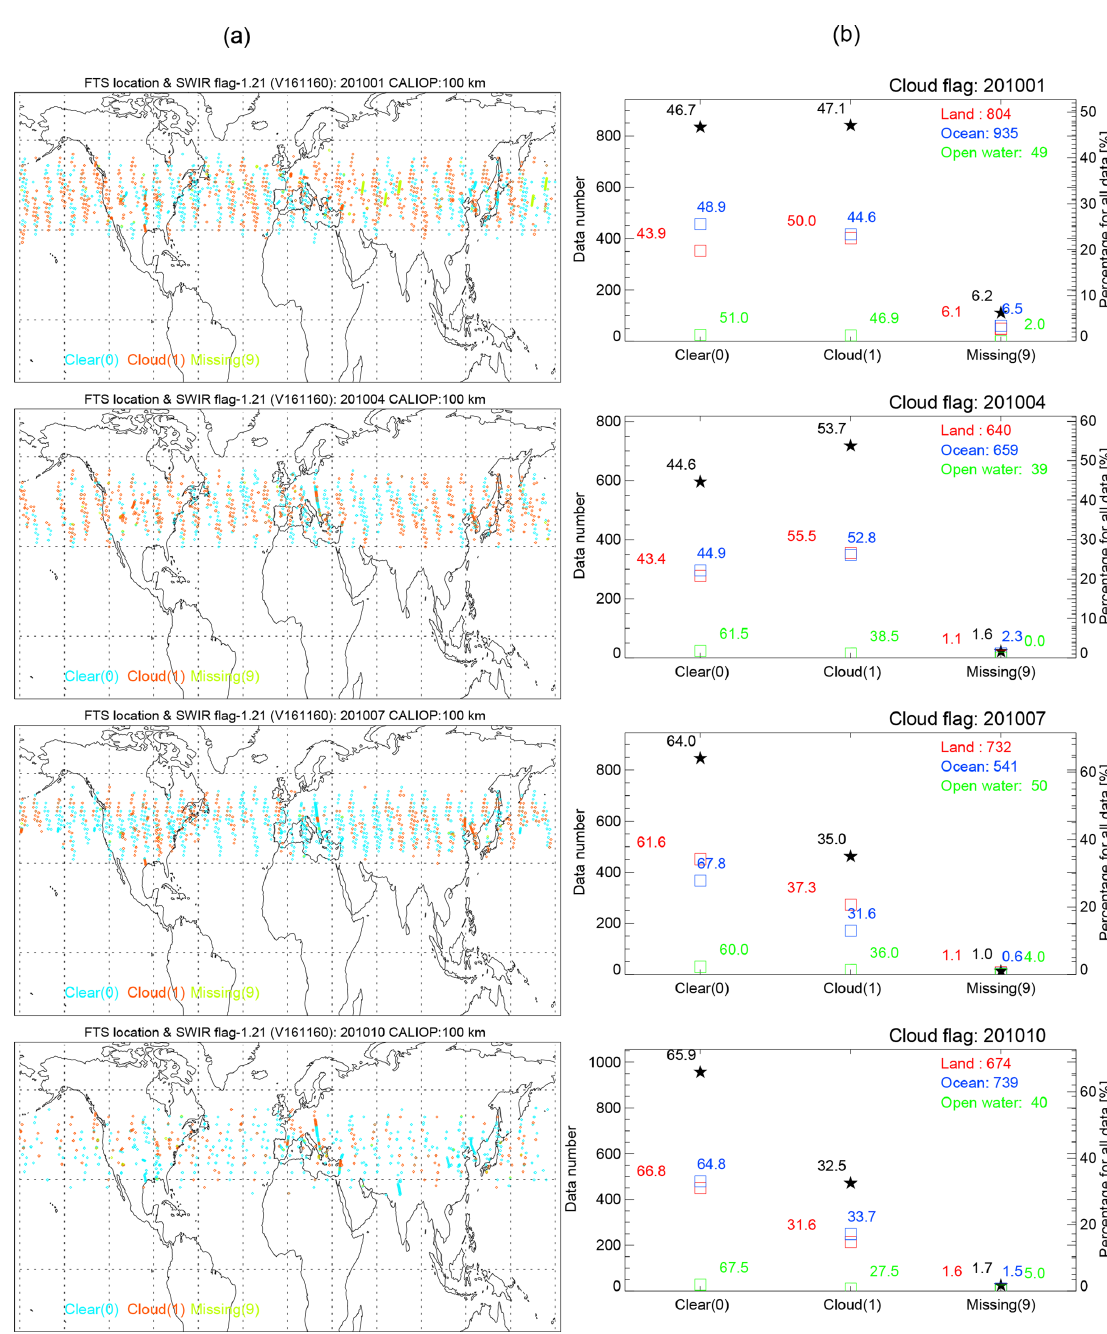
Figure 6. (a) Maps of match-up observation points for TANSO-FTS and CALIOP, colored according to the TANSO-FTS cloud flags: clear, cloud and missing are shown in light blue, orange and light green, respectively. (b) Among the data selected for comparing with CALIOP, the fraction of each cloud flag that has been derived from TANSO-FTS observations. The red, blue and green colors indicate observations over land, water and open water, respectively. The total data numbers in each case are given in the (b) . The black star symbols indicate the data number and the percentage with respect to the total dataset is also shown. The open squares in red, blue and green show values over land, ocean and open water, respectively, and the values to the left or right of the square are the percentage of each cloud flag with respect to the total number of data. Results are shown (from top to bottom) for January, April, July and October